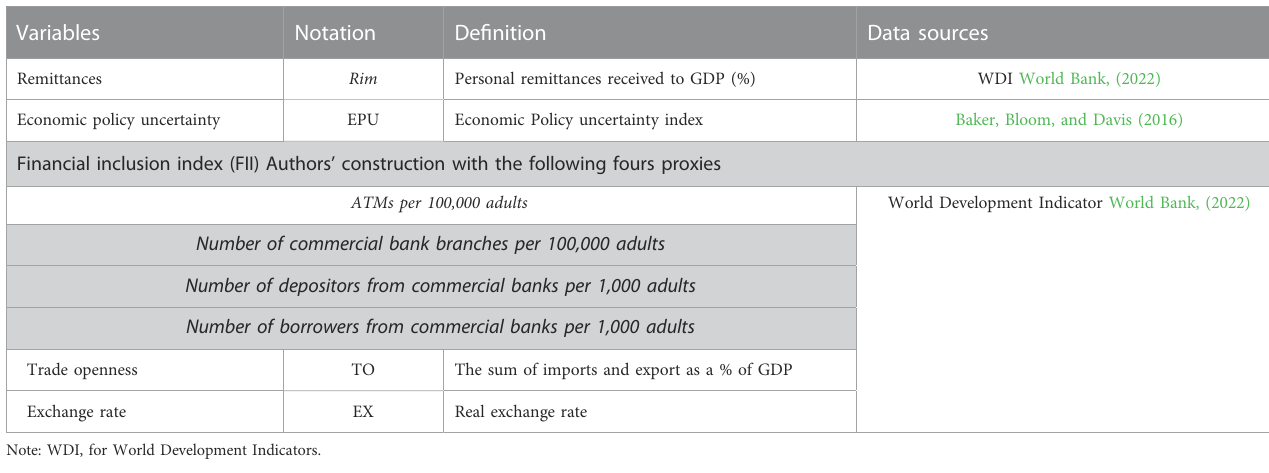
TABLE 1 Variables de fi nition and data sources.